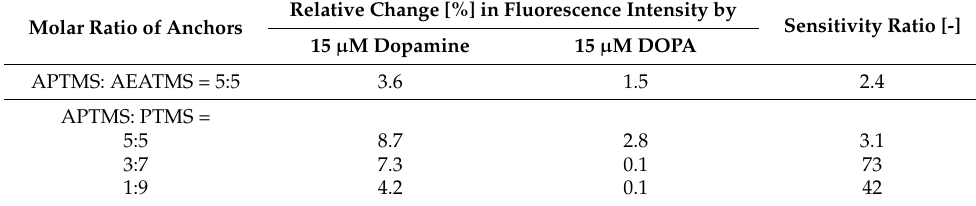
Table 1. Effect of sensitivity and selectivity of the fluorescent intensity of fMIP-NP using dopamine template immobilized by the blended silane couplers.